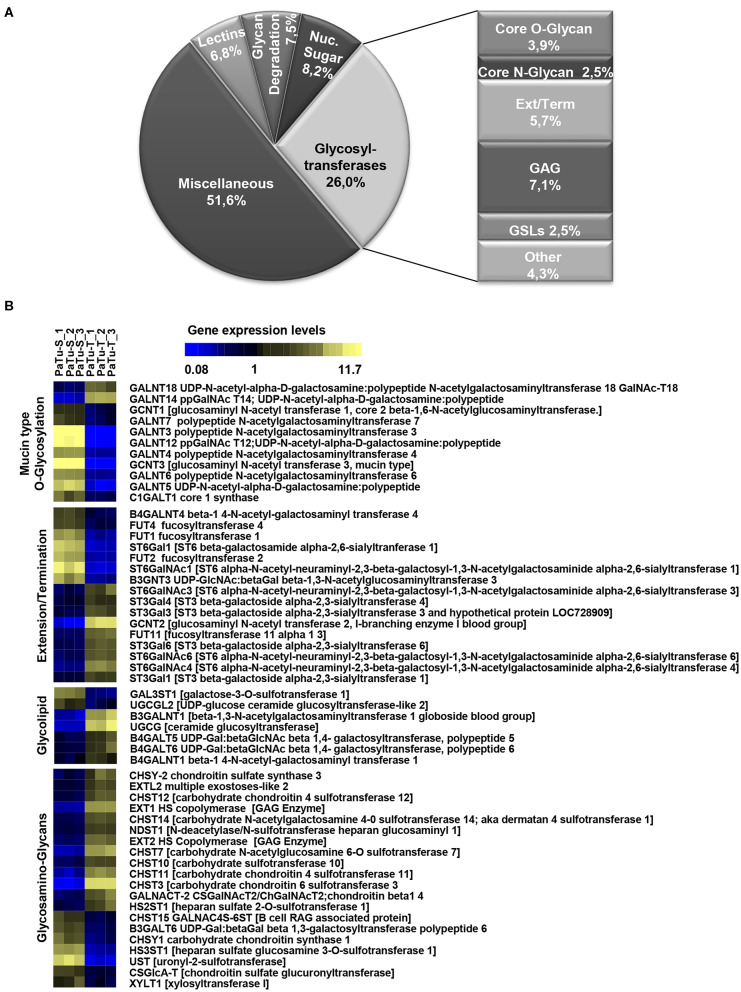
Expression levels of glycosylation-related genes in PaTu-T and PaTu-S cell lines. (A) Glyco-gene transcripts with more than 1.5-fold difference in transcription levels between the two cell lines (281 from a total of 1,171 gene transcripts) clustered according to their putative function. The miscellaneous group includes genes related to glycosylation such as growth factors, receptors, interleukins, and adhesion molecules. Glycosyltransferases (GTs) comprises 73 of the 281 genes (26%) and are classified according to their assumed role in biosynthesis of target structures like O-glycan core, N-glycan core, GAG (glycosaminoglycan), GSLs (glycosphingolipids), Term (terminal modifications of various types of glycan structures), and Ext (extension of the various types of glycan structures). (B) TreeView of GT gene expression levels in PaTu-S and PaTu-T. Expression levels are depicted from low expressed genes (dark blue), through middle range gene expression (black) to highly expressed genes (yellow).